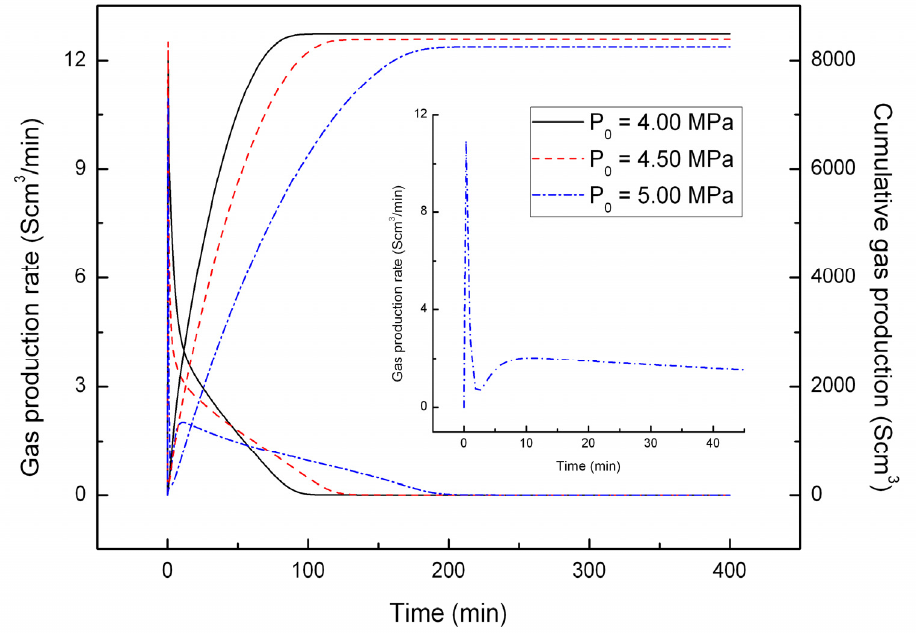
Figure 4. Gas production rate and cumulative gas production time evolution for different initial pressures with the same depressurizing range.